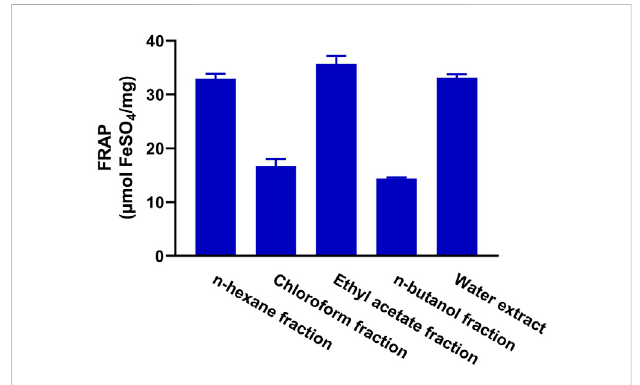
FIGURE 3 FRAP of the fractions of MEACL. Data are Mean ± SEM ( n = 3).